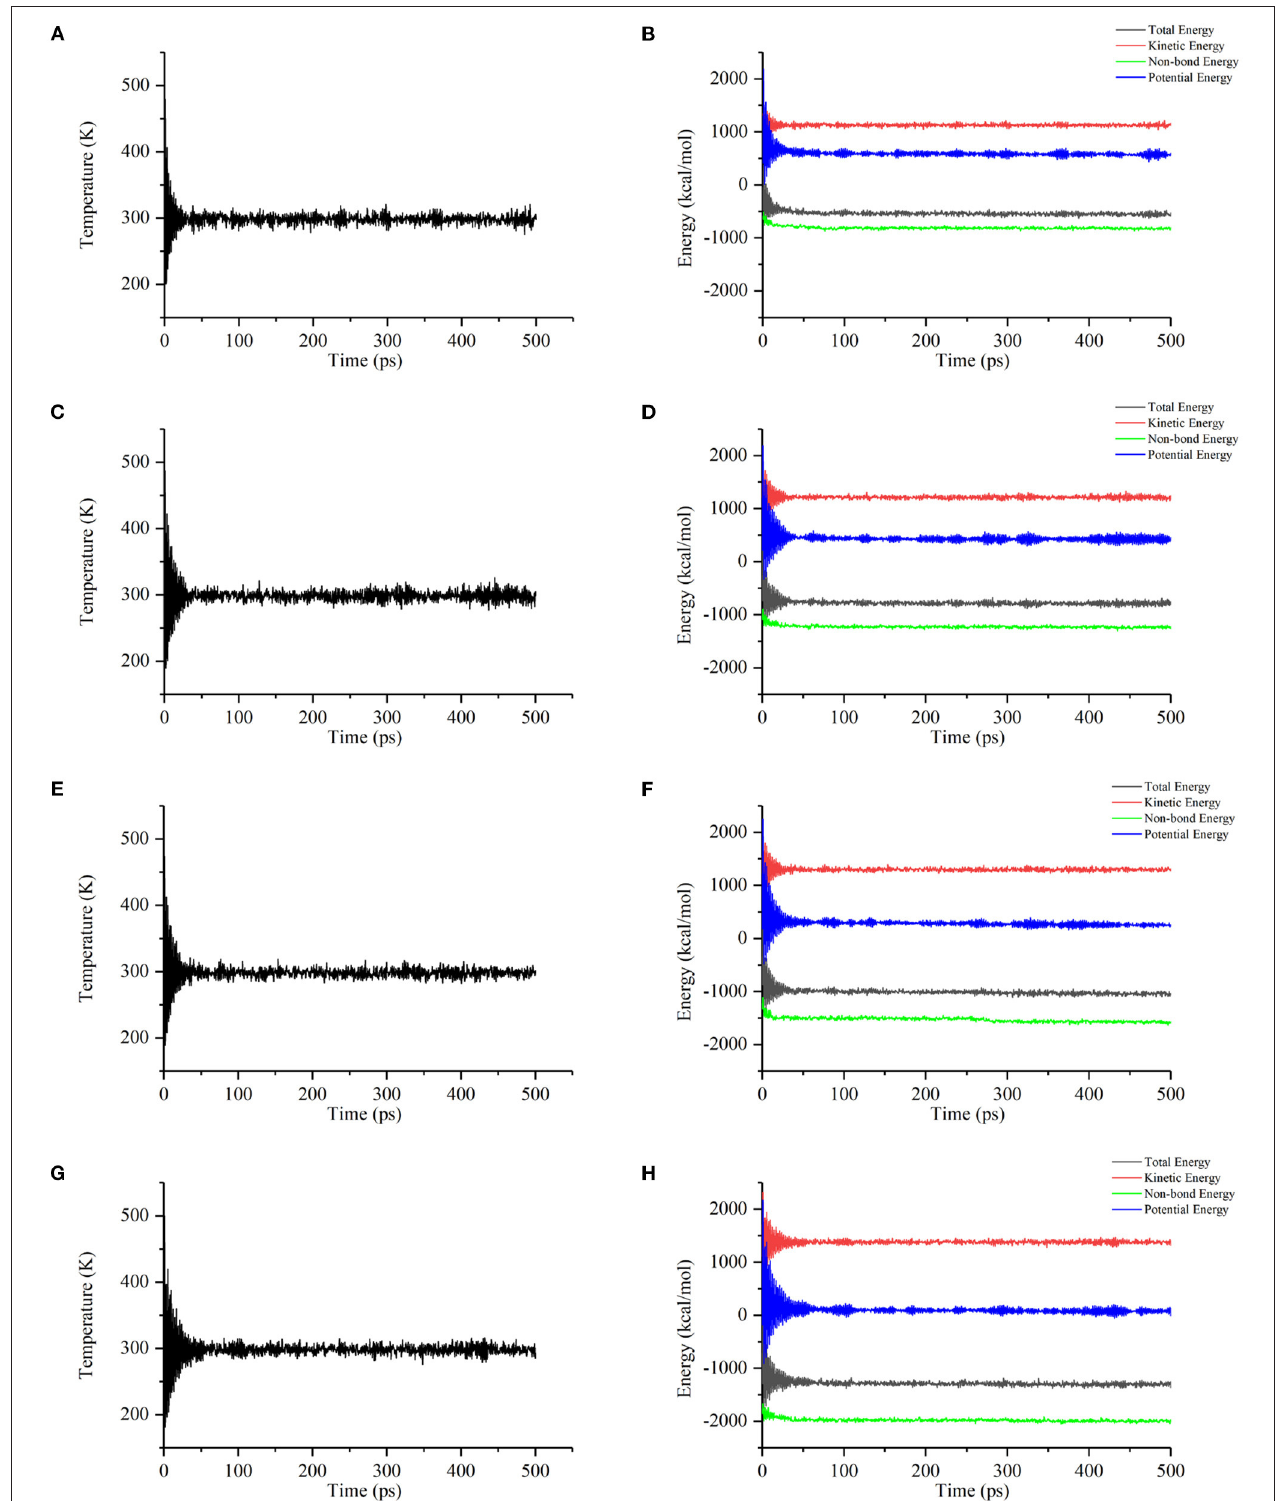
FIGURE 7 | Changes of temperature and energy with time in simulation systems, temperature change of 0PC S (A) , energy change of 0PC S (B) , temperature change of 1PC S (C) , energy change of 1PC S (D) , temperature change of 2PC S (E) , energy change of 2PC S (F) , temperature change of 3PC S (G) , and energy change of 3PC S (H)